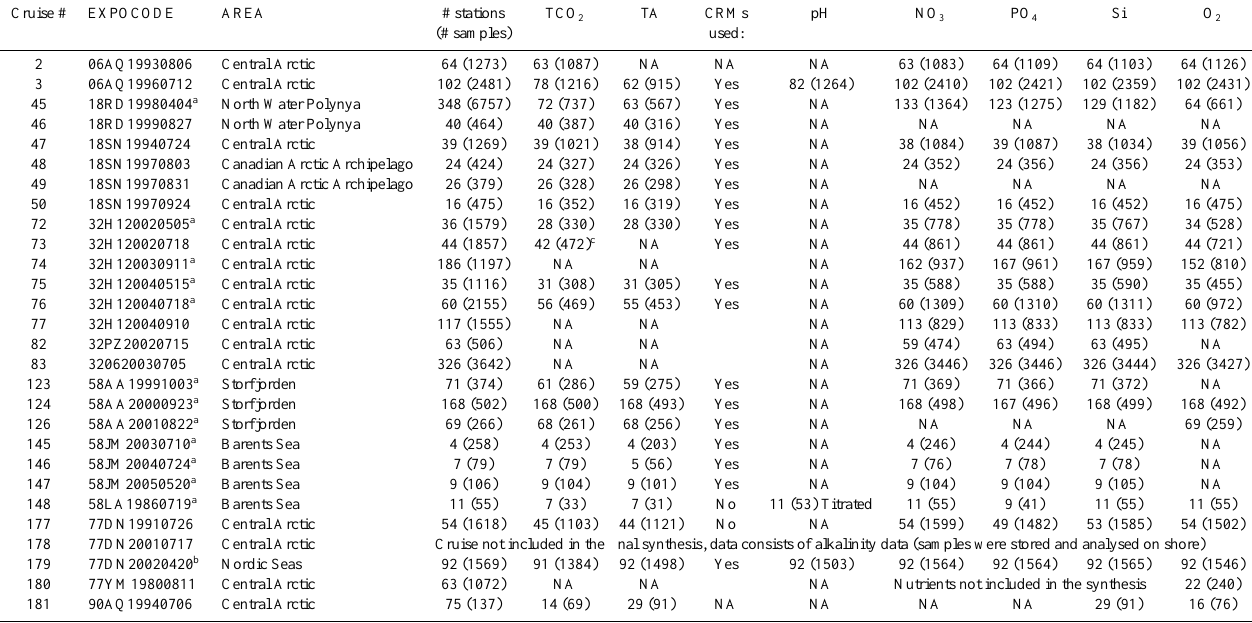
Table 1. Cruises and parameters included in the Arctic Ocean synthesis in CARINA listed together with the number of stations and samples (flagged 2 in the CARINA.AMS.V1.2). Note that the number of stations and samples can di ff er from the ones in the Carina table at CDIAC for that reason.